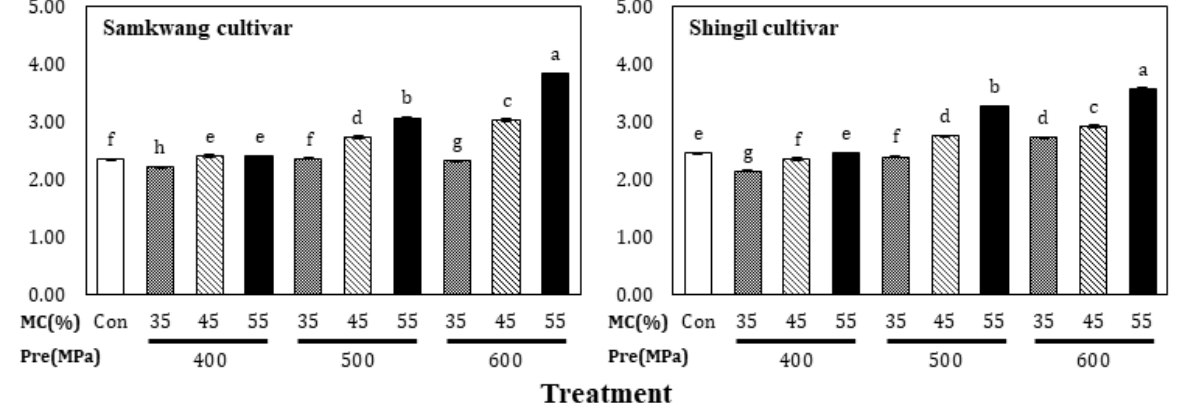
significant result as determined by Duncan’s range test ( p < 0.05) according to the treatment